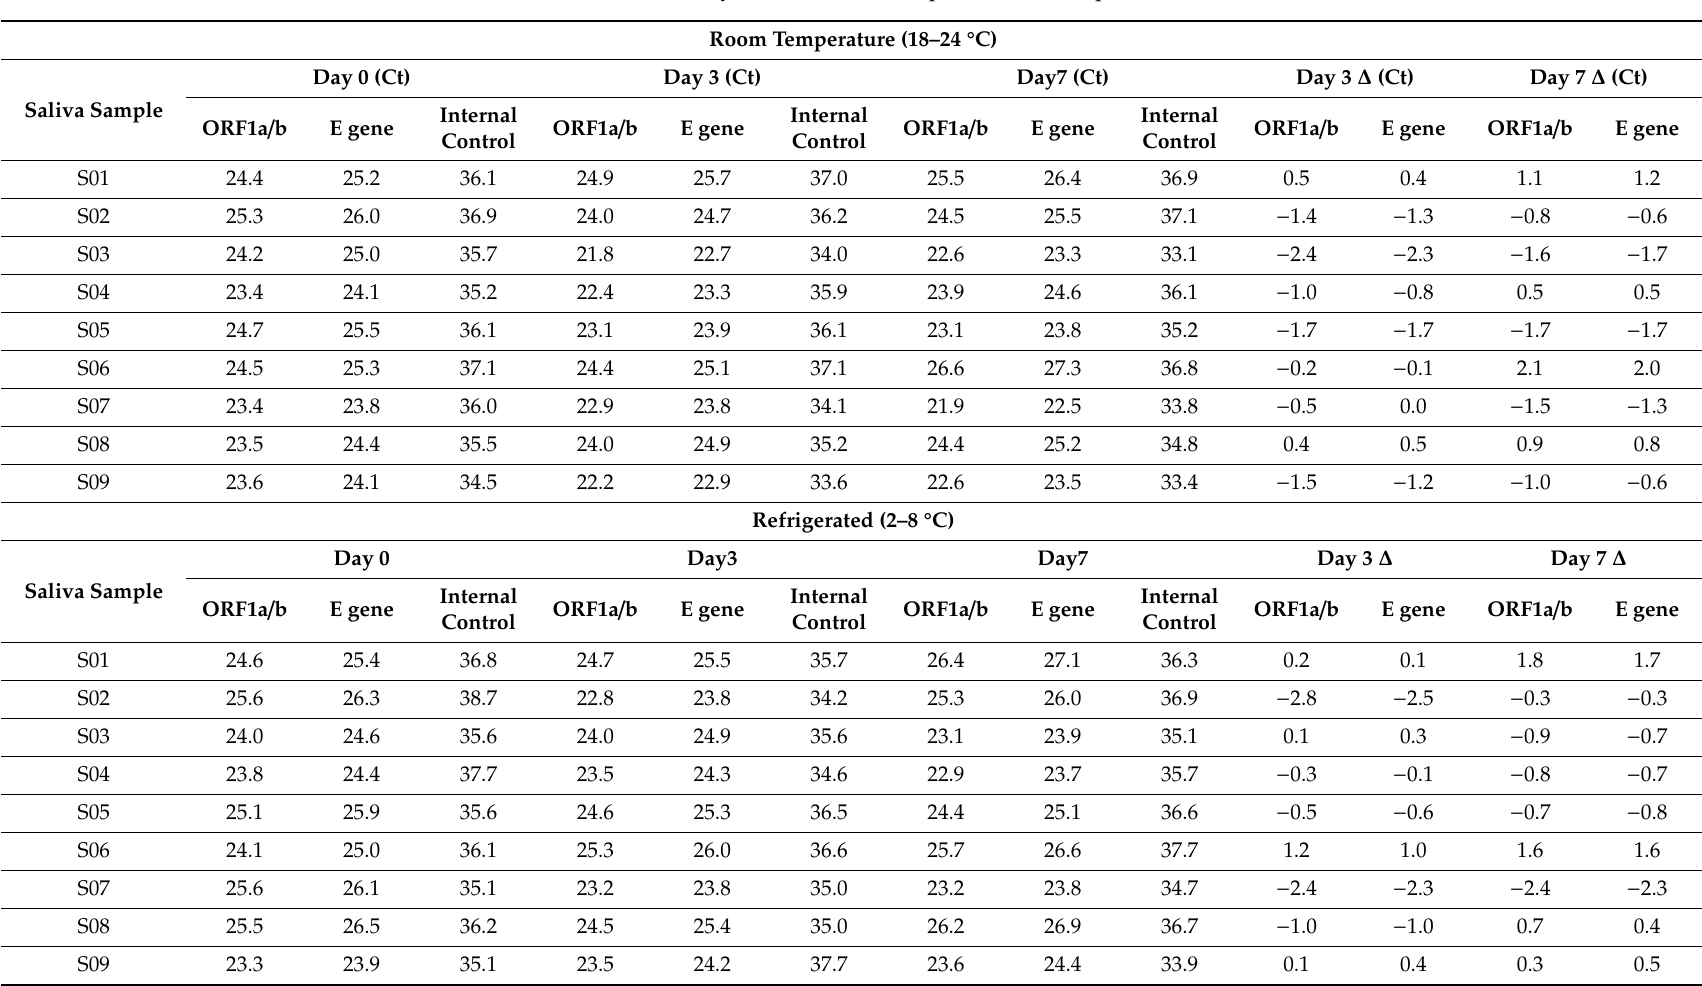
Table 3. Stability of SARS-CoV-2 in spiked saliva